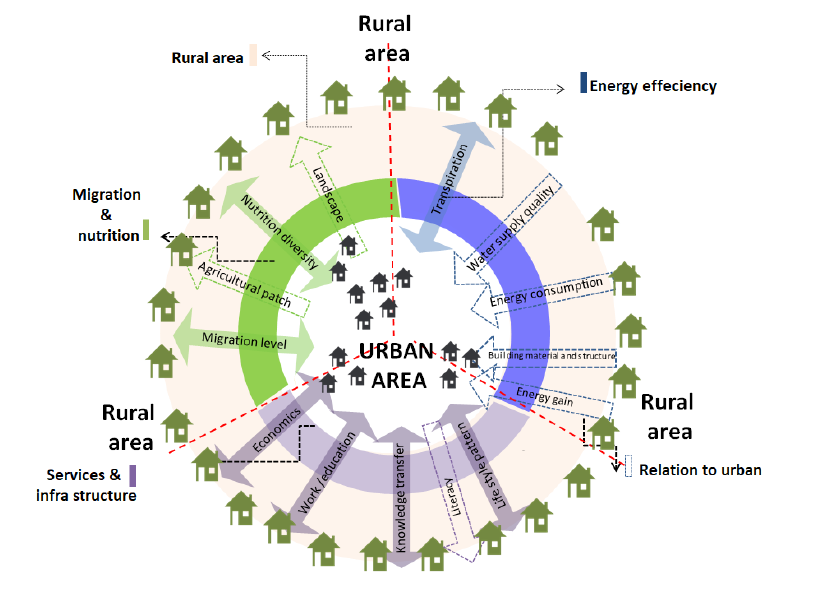
Figure 2 Exchanges and interactions of the rural-urban-metabolism Source: Adapted from Repp et al. 2012 by researchers